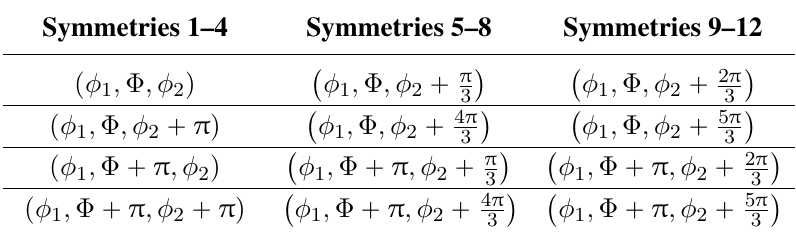
Table 1. Twelve symmetry operations within hexagonal close packed (HCP) rotational point symmetry